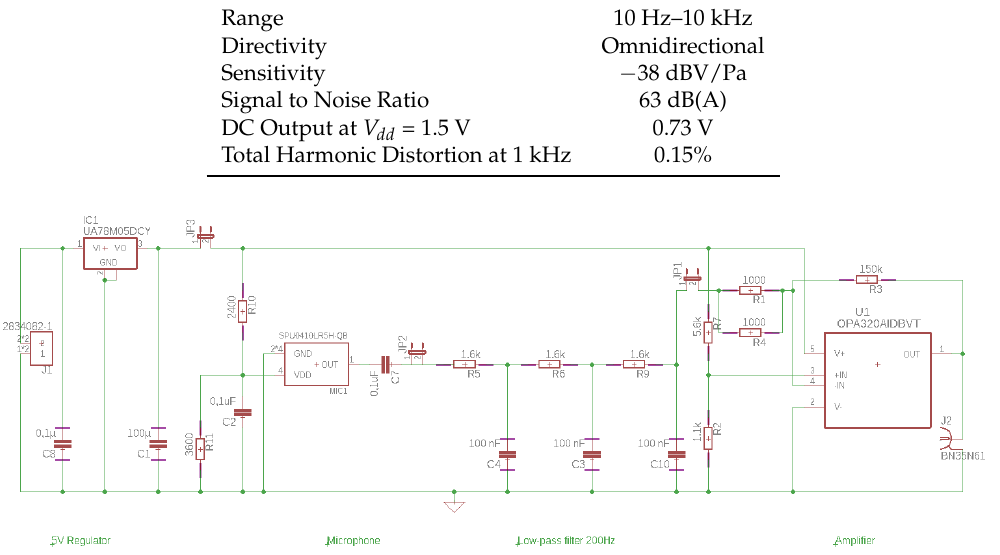
Figure 4. Schematic representation of the conditioning board.